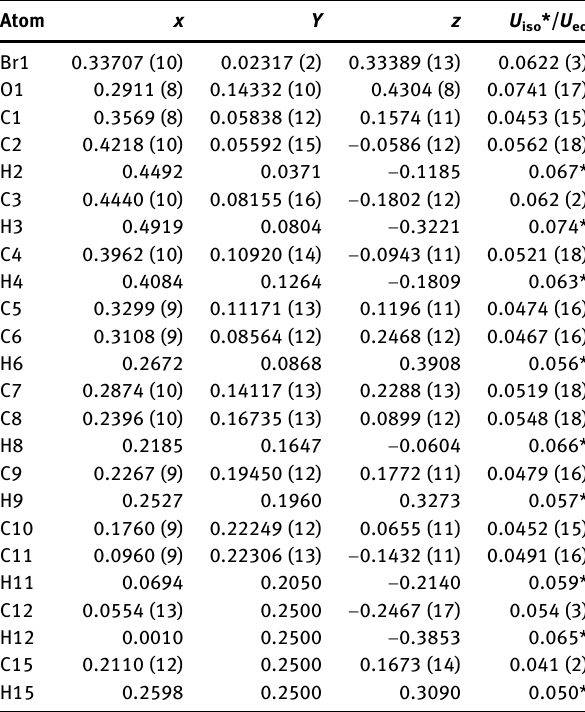
Table  : Fractional atomic coordinates and isotropic or equivalent isotropic displacement parameters (Å 